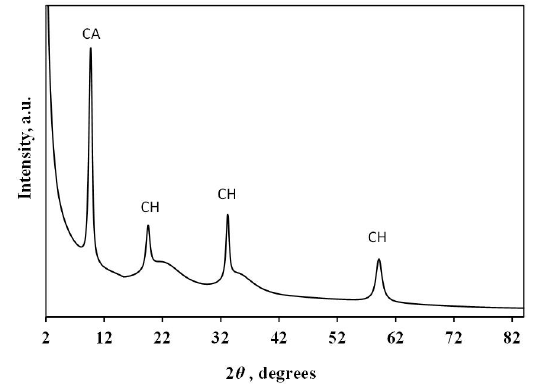
Figure 1. XRD pattern of as-deposited cobalt hydroxide film. Indexes: CA – cobalt acetate, CH – cobalt hydroxide.